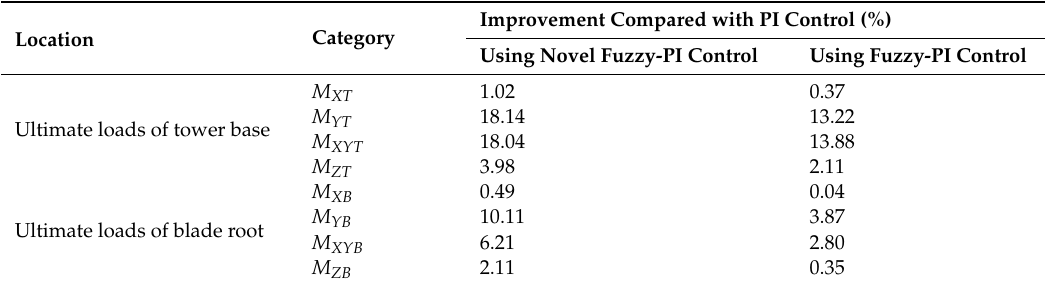
Table 7. Analysis of ultimate loads under extreme turbulent wind